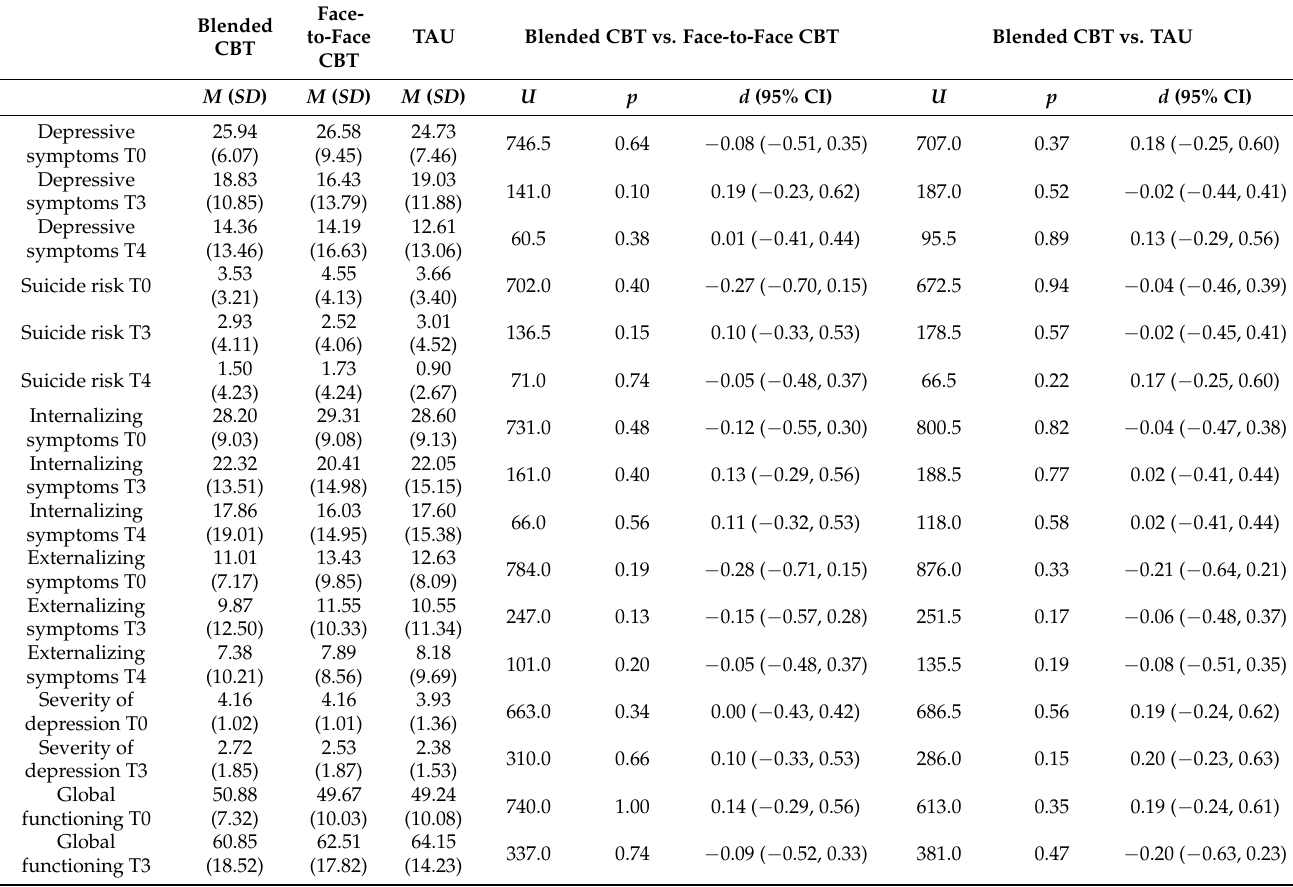
Table 2. Between-group differences and effect sizes in secondary